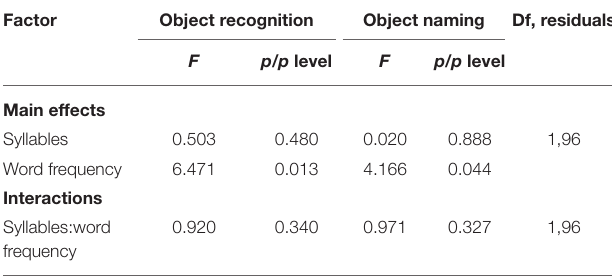
TABLE 7 | Influence of word-specific factors on object recognition and naming.